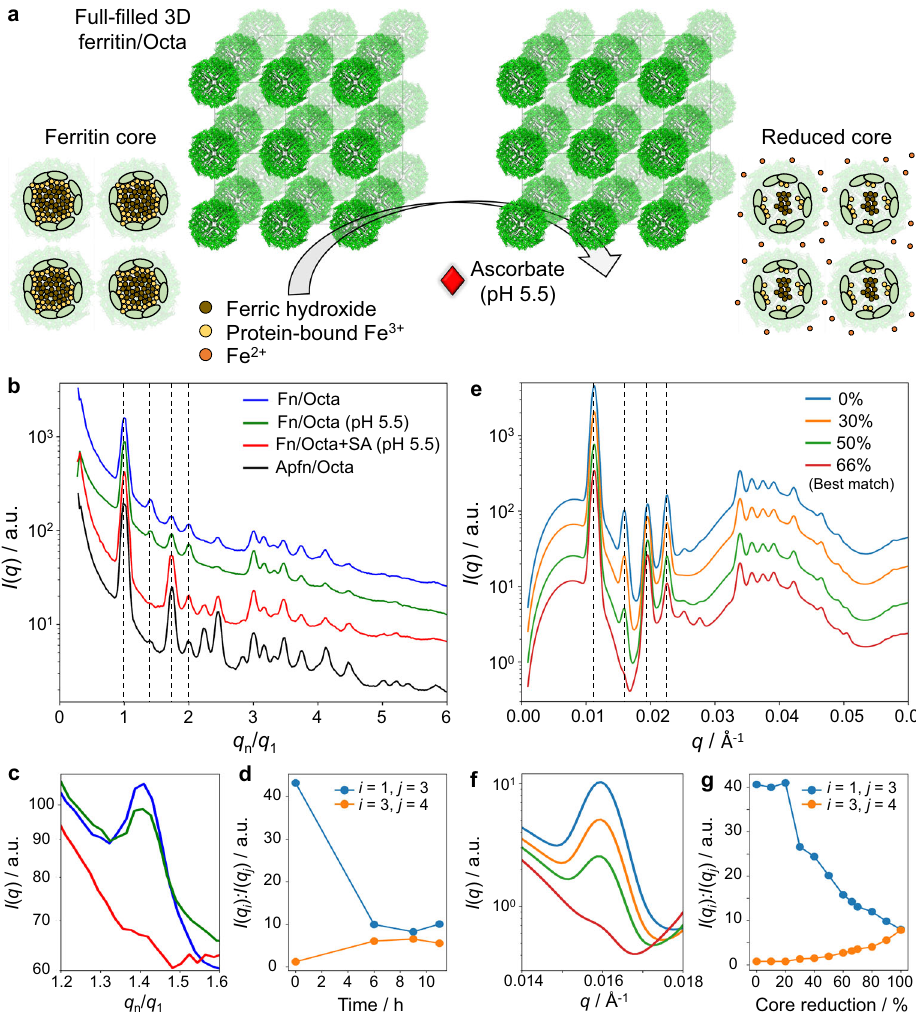
Fig. 6 Conversion of ordered 3D (SC) ferritin array into an apoferritin array. a Schematic view showing the conversion of a 3D ferritin into apoferritin array by reduction using sodium ascorbate (SA), see text for details. b In situ SAXS analysis showing the conversion of 3D ferritin/Octa lattice (Fn/Octa, blue) into an apoferritin/Octa (Apfn/Octa) lattice after 9h incubation with SA (red) solution containing ammonium acetate (NH 4 Ac, pH 5.5), and controls, Fn/Octa in NH 4 Ac (green) and a native Apfn/Octa lattice (black). Peak positions were normalized by the center of the 1st peak. The peaks that changed their relative intensities during conversion were shown by the dashed lines. Intensity pro fi les were shifted by a factor two for clarity. c The changes in the intensity of the 2nd SAXS peak (corresponded colors in b ). d Analysis of the time-dependent study (Supplementary Fig. 43) showing relative peaks intensities between the 3rd and 4th (orange), and the 1st and 3rd (blue) peaks, indicating that the reduction process completed after 6h. e Conversion of the ferritin array was analyzed by SAXS modeling (route 1 is shown, see text for details; intensities were shifted vertically for clarity by factor two), which indicated about 66% reduction of ferritin array. f SAXS modeling and analysis of the 2nd peak in c agreed with the experimental results. g Estimated degrees of core reduction based on SAXS modeling (see “ Methods ” section and Supplementary Figs. 44 and 45). Routes 2 and 3 for core dissolution pathways (Supplementary Figs. 46f and 47f), resulted in close values in the range of 60 ‒ 75% of reduced proteins (10 µM) in PBS and reacted overnight at 4°C. The DNA grafted proteins were puri fi ed by fi lter units (100 kDa) and centrifuged at 3000 × g and 4°C for 9 times. The protein products were concentrated to 10µM and stored at 4 °C. UV-vis was used to estimate protein concentration and the number of ssDNA on protein surfaces (about 6 ‒ 7 ssDNA per ferritin), see Supplementary Fig. 4. To encapsulate protein in single Octa frames, Octa was mixed with the proteins (typically 40nM for 30nM Octa) in the TAE/MgCl 2 buffer and the mixed solution was heated up to 48°C and cooled to room temperature over 40 ‒ 60 h. Note that a lower starting temperature and shorter cooling time at higher temperatures should be considered depending on the protein stability. Negative-stained TEM imaging . In brief, Octa and protein/Octa (5 μ L, 5 – 10 nM) solutions were dropped on a carbon fi lm for 2min and the residual liquid was removed with a piece of fi lter paper. After that, the grid was washed with 5 μ L of deionized water followed by staining with 5 μ L of 2 wt % uranyl acetate for 10 s. The excess liquid was removed with fi lter papers. TEM imaging was performed on a JEOL 1400 TEM, operating at 120kV. The yields of protein encapsulation were